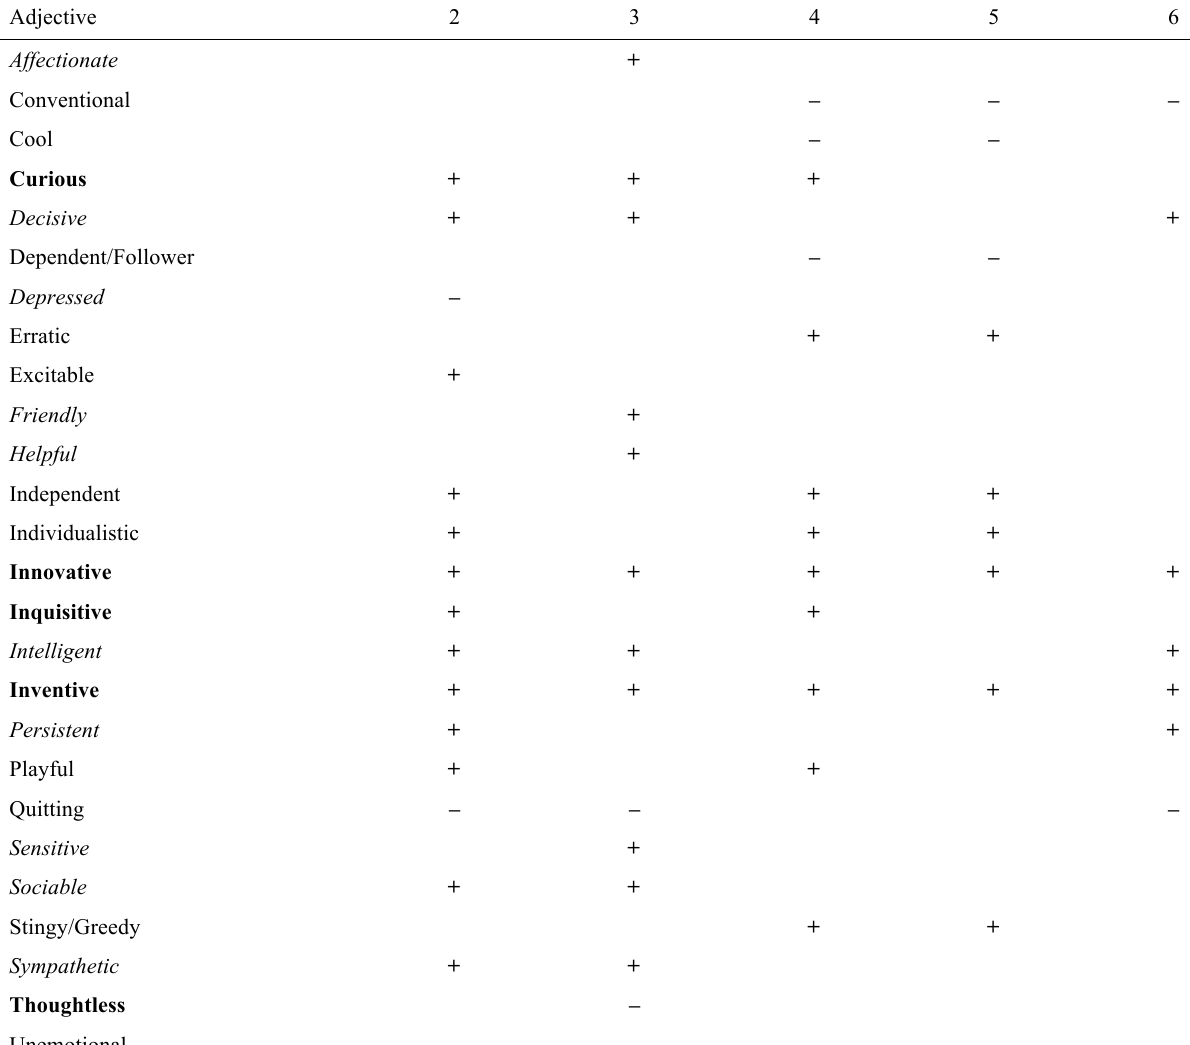
Common Correlated Items across Five Exploratory Factor